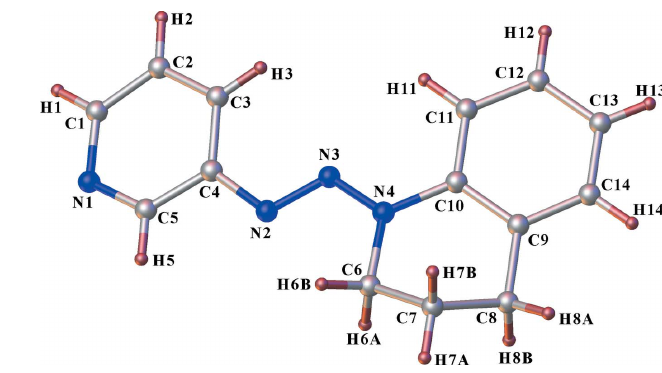
Figure 1 A view of the title compound I , showing the atom-numbering scheme. Displacement ellipsoids are plotted at the 30% probability level.